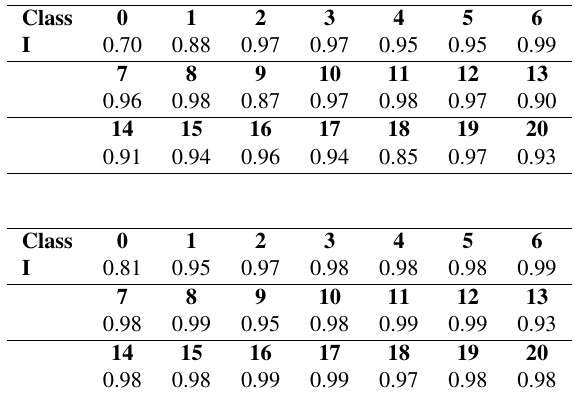
Table 2. ScanNet normalised confusion matrix intersection ( I ) values for no augmentations (a) and weighted augmentations (b) processing